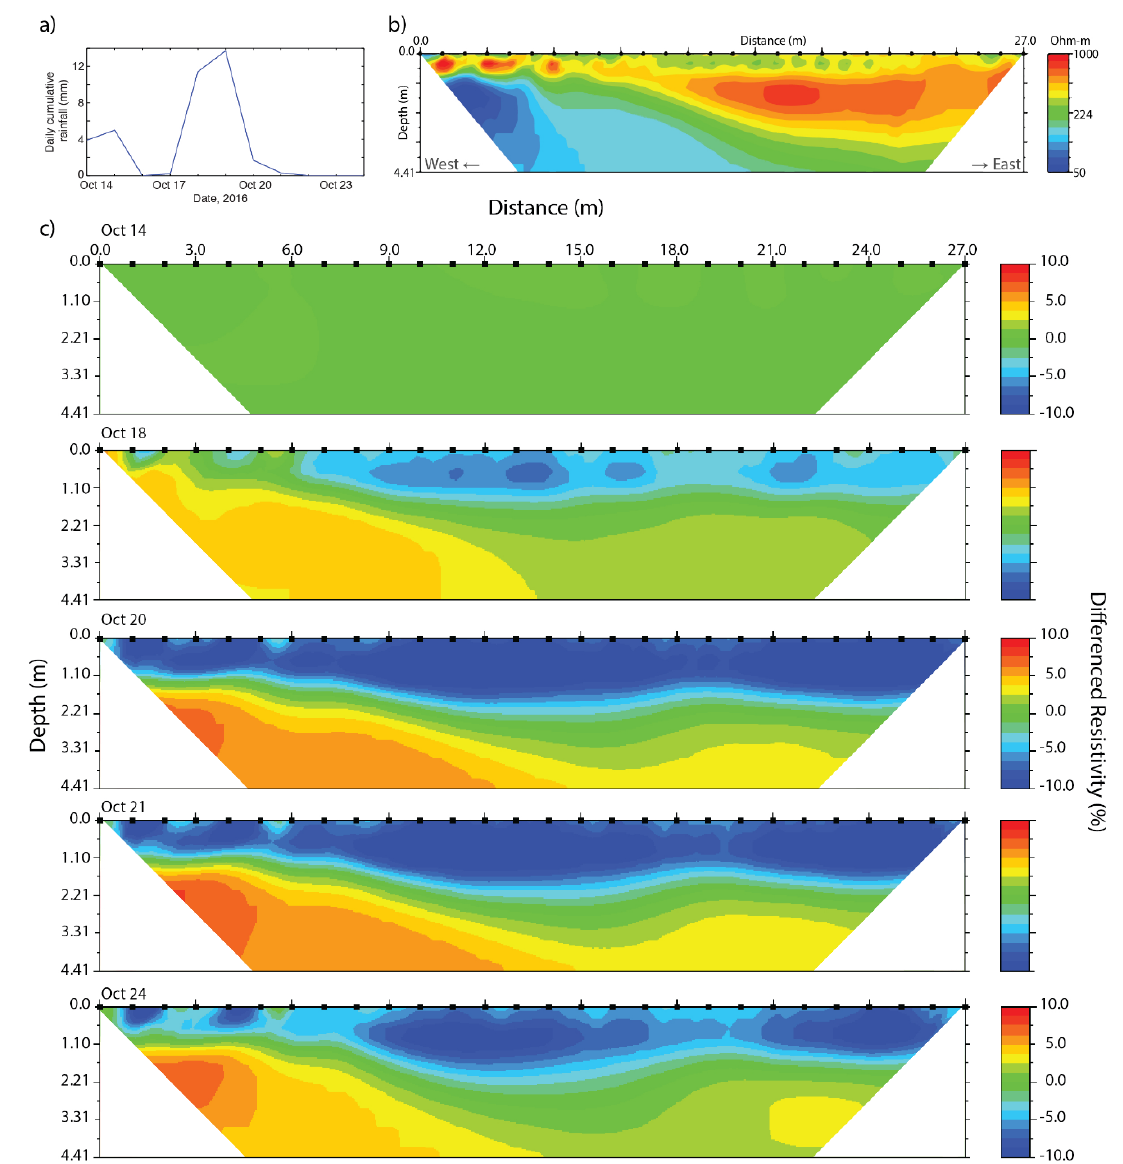
Figure 9. Time-lapse resistivity profiles, indicating soil moisture dynamics, with ( a ) rainfall from 14 October to 24 October, ( b ) the base profile of 14 October, and ( c ) the differenced profiles from 14 October to 24 October. Note the anomaly at the far left side of the profile (further discussed in the text).